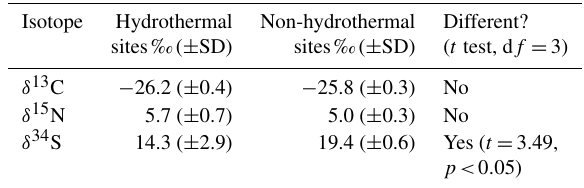
Table 5. Mean isotopic signatures of sediment organic